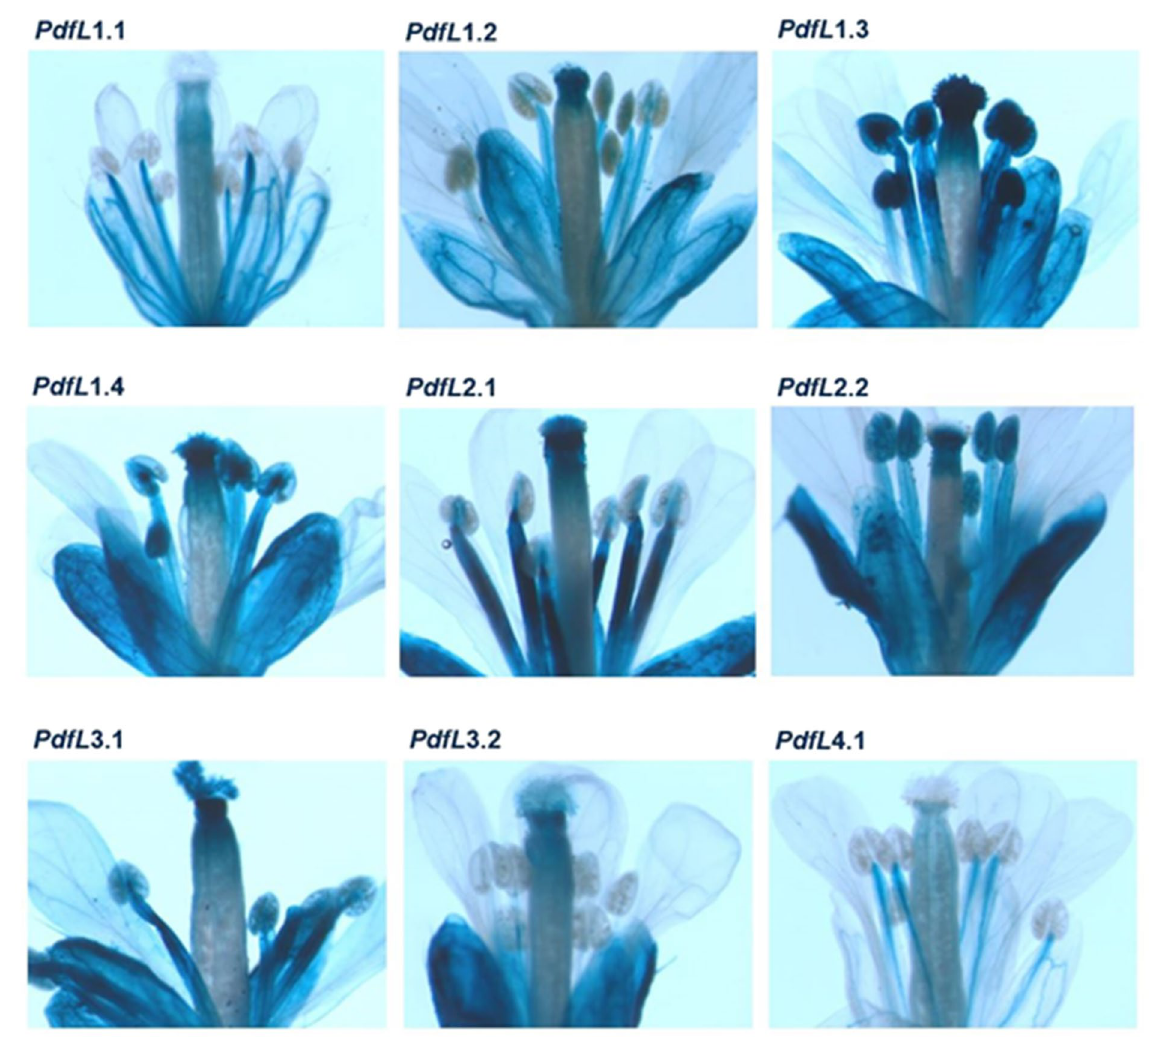
Figure 5. Expression of PdfL s in flowers. GUS staining of promoter::GUS lines.